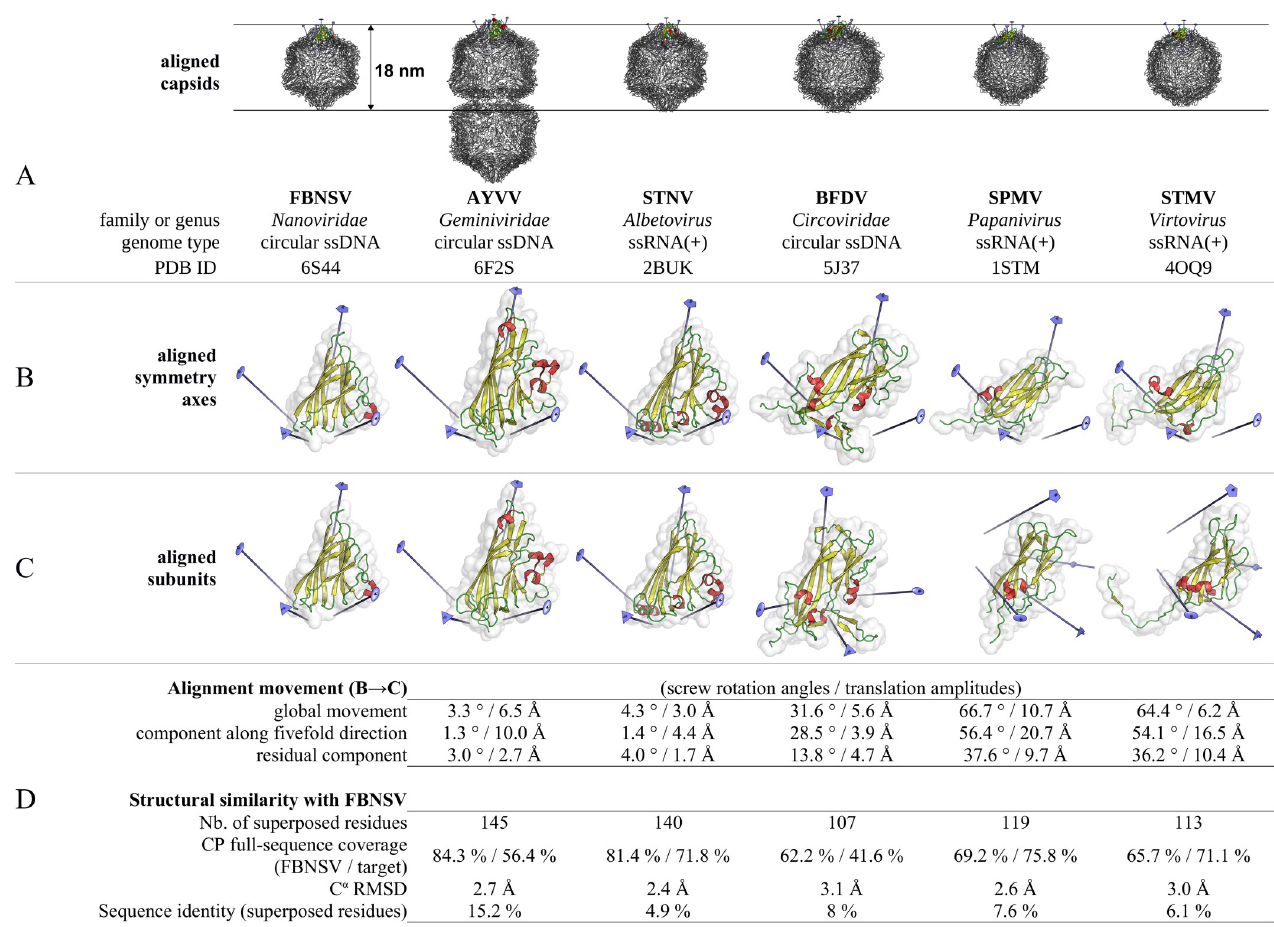
Fig 7. Comparison of the FBNSV capsid structure with those of other T = 1 icosahedral (or geminate pseudo-icosahedral in the case of AYVV) viruses. All virus acronyms are explained in the text, except BFDV: beak and feather disease virus. (A) Outline of the whole capsid structures. The capsids are aligned to each other with respect to their symmetry axes (half-capsid pseudo-symmetry axes in the case of AYVV). A single CP subunit in each structure is highlighted in colours. The five-, three- and twofold axes closest to the highlighted subunits as well as the second closest twofold axis are drawn. The vertical direction corresponds to a fivefold direction. (B) Side-by-side representation of single CP subunits oriented so that the capsid (pseudo)symmetry axes are aligned to those of FBNSV (which is oriented as in Fig 2D). The five-, three- and twofold axes closest to each subunit as well as the second closest twofold axis are drawn. Note that the twofold axis closest to the FBNSV, AYVV and STNV subunits (on the bottom right of each subunit picture) does not correspond to the twofold axis closest to the BFDV, SPMV and STMV subunits (on the left of each subunit picture). (C) Side-by-side representation of single CP subunits oriented after structural superposition onto the FBNSV CP subunit (FBNSV oriented as in Fig 2D). (D) Details of the virtual superposition movement (B ! C) decomposed into two movements (one around the fivefold direction and the residual around a perpendicular direction) and statistics of the structural comparison with FBNSV. The arrangement of the CP subunits relative to each other in FBNSV resembles that of STNV and AYVV (half capsid). On the other hand, and despite the overall conserved jelly-roll fold, a significantly different arrangement is observed in BFDV, SPMV and